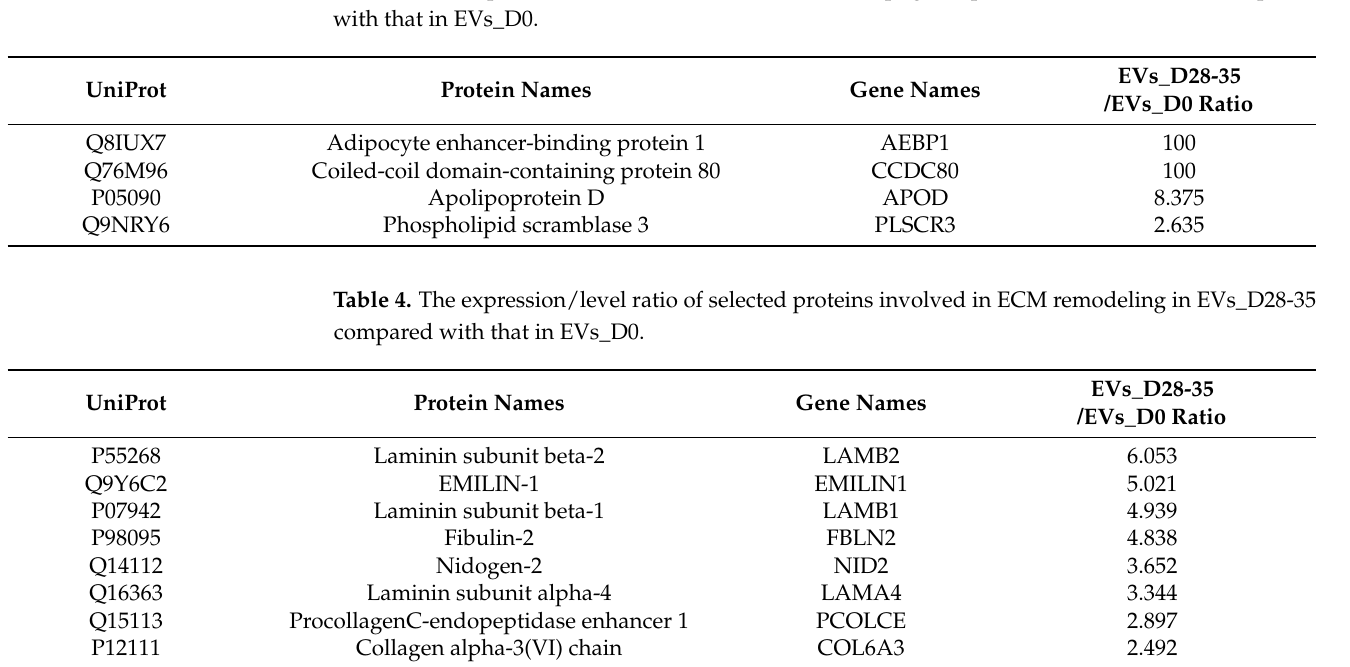
Table 5. GO terms related to cell metabolism (proliferation, apoptosis, viability) in the GO